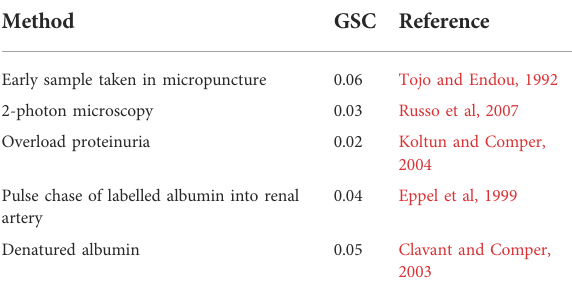
TABLE 3 Summary of albumin GSC values obtained in healthy rats by different methods where the confounding retrieval pathway has been